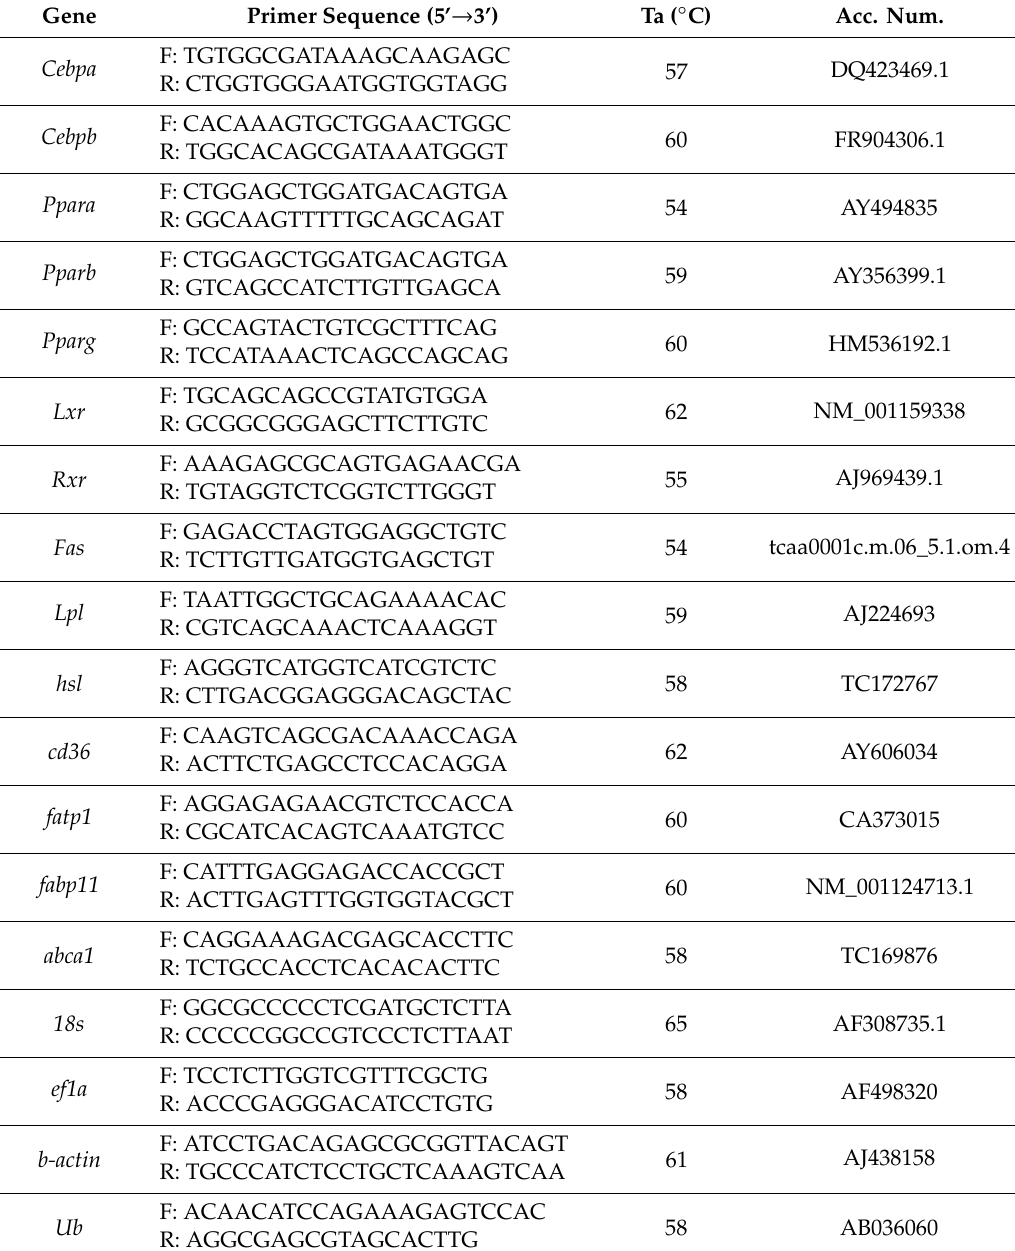
Table 2. Rainbow trout primers used for real-time quantitative PCR. F, forward primer; R, reverse primer; Ta, annealing temperature; Acc. Num., GenBank accession